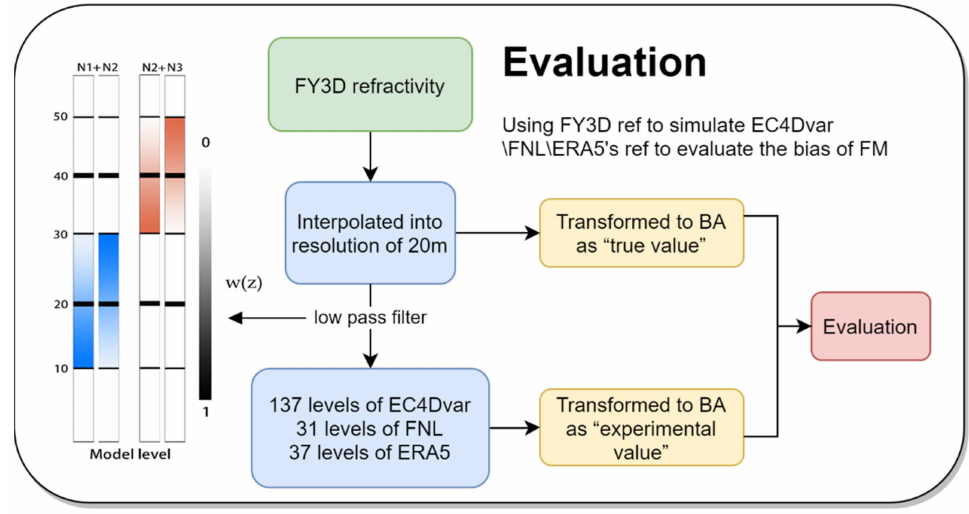
Figure 2. Flow chart of experiment two, evaluation of forward modeled